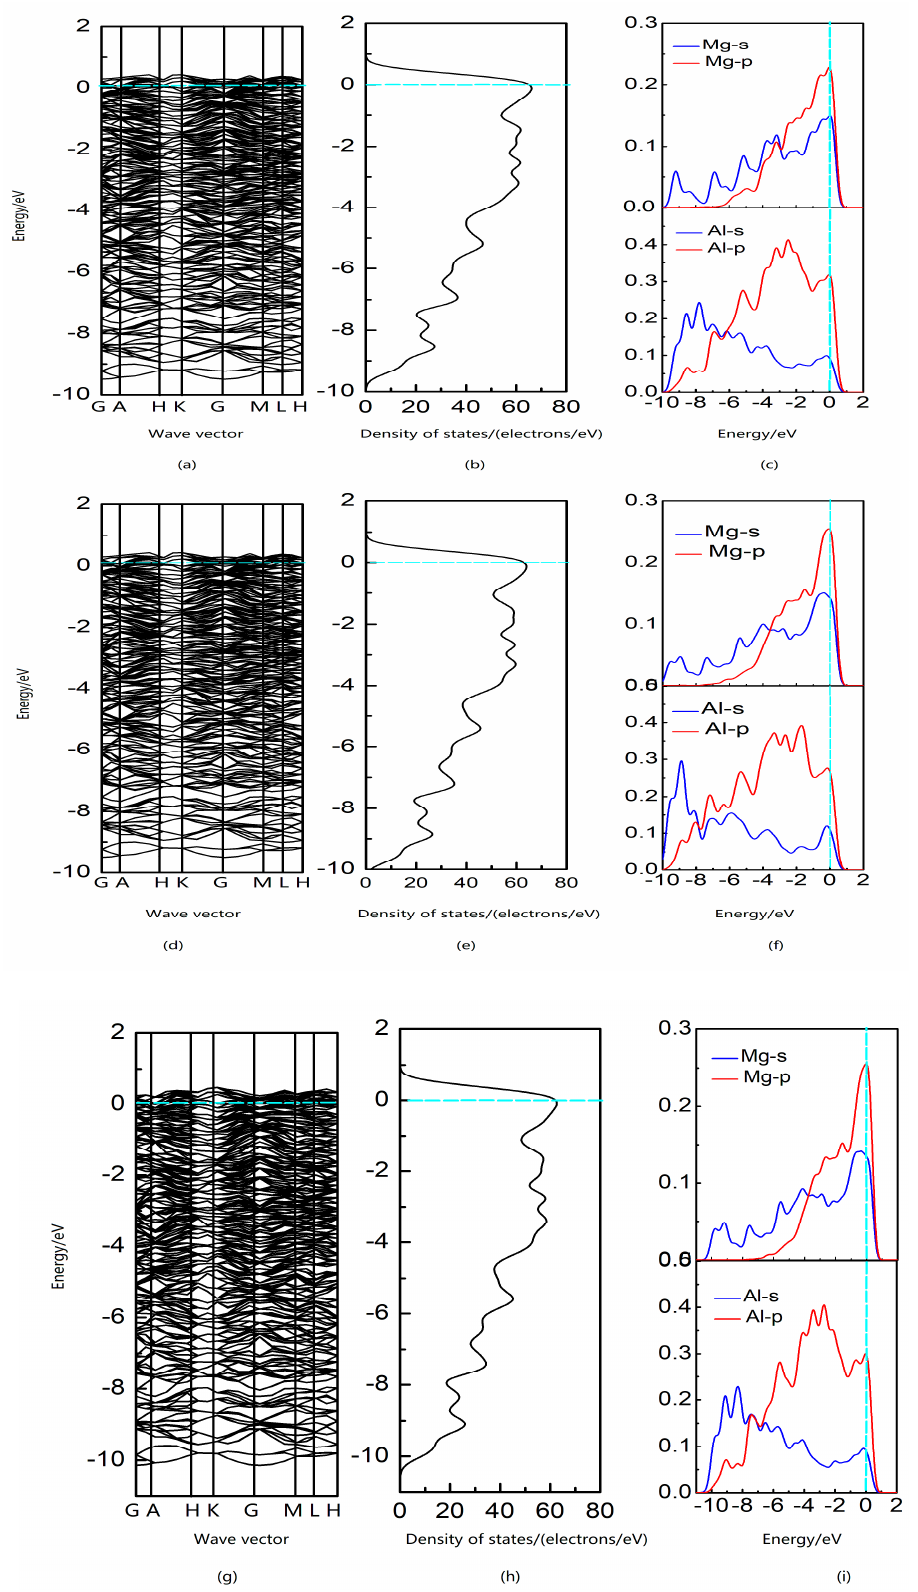
Figure 3. Calculated band structure: ( a ) at 0 GPa, ( d ) at 4 GPa, ( g ) at 8 GPa; total density of states: ( b ) at 0 GPa, ( e ) at 4 GPa, ( h ) at 8 GPa; partial density of states: ( c ) at 0 GPa, ( f ) at 4 GPa, ( i ) at 8 GPa; the Fermi level is indicated by the blue dotted line.